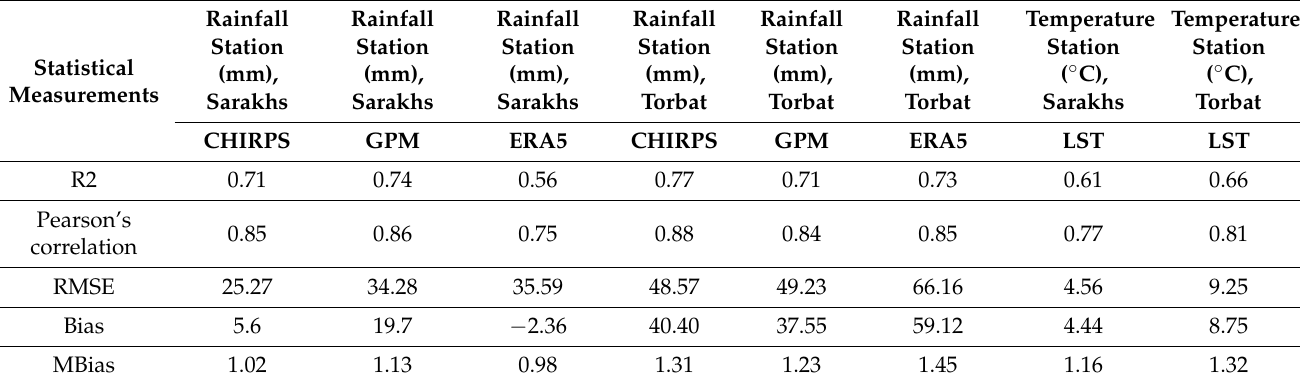
Table 2. Comparing observed and gridded datasets’ (CHIRPS, GPM and ERA5 for rainfall and LST for temperature) spatial similarities using statistical indices for the period from 2001 to